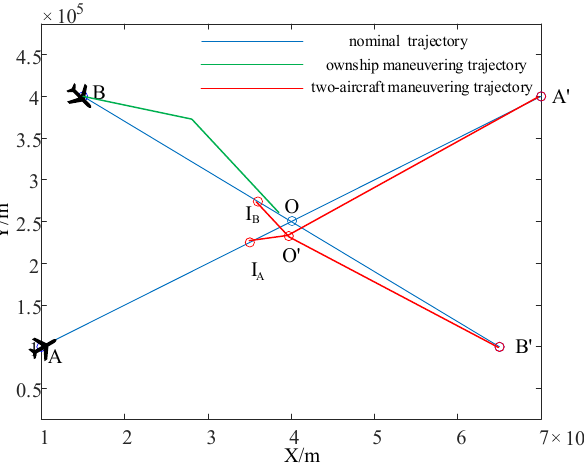
Figure 11. Comparison diagram of own ship and two-aircraft separation assurance strategy.